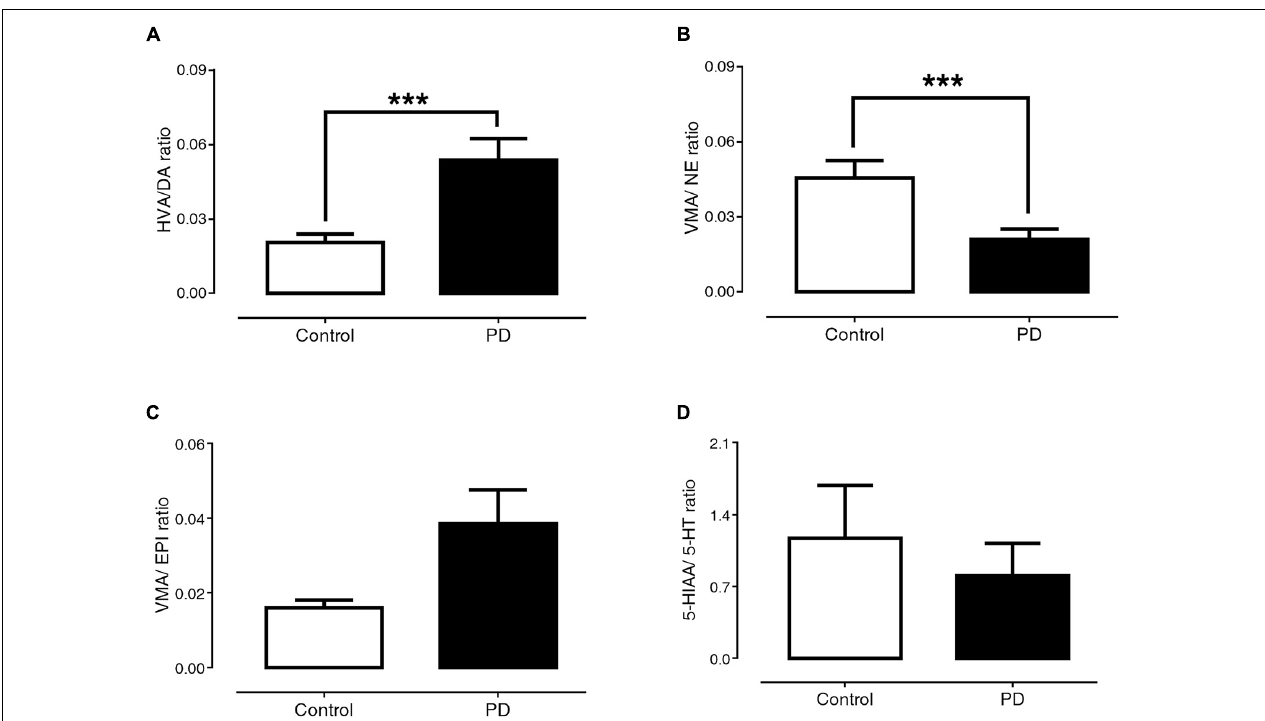
FIGURE 3 | Comparisons of HVA/DA (A) , VMA/NE (B) , VMA/EPI (C) , and 5-HIAA/5-HT (D) ratio between control subjects and PD patients. Data are presented as mean ± SEM (*** p < 0.001).